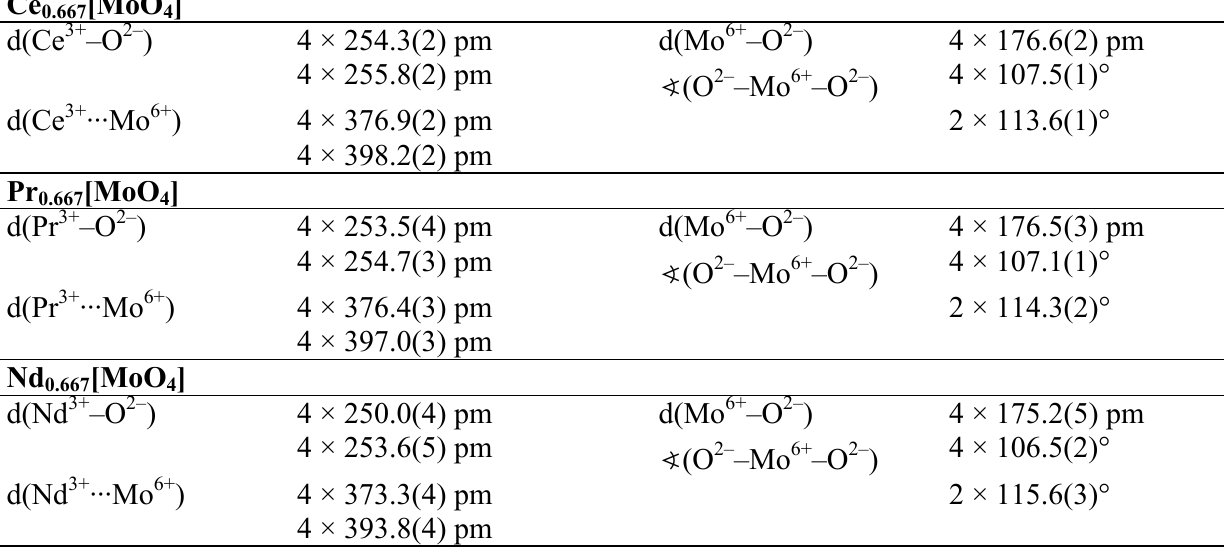
Table 2. Selected interatomic distances and bond angles in the crystal structures of the [MoO ] ( Ln = Ce, Pr, Nd, and scheelite -type series Ln 0.667 4